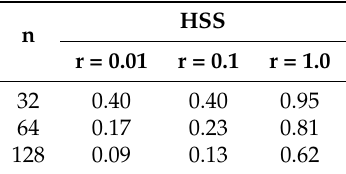
Table 4. The optimal values α exp for HSS.